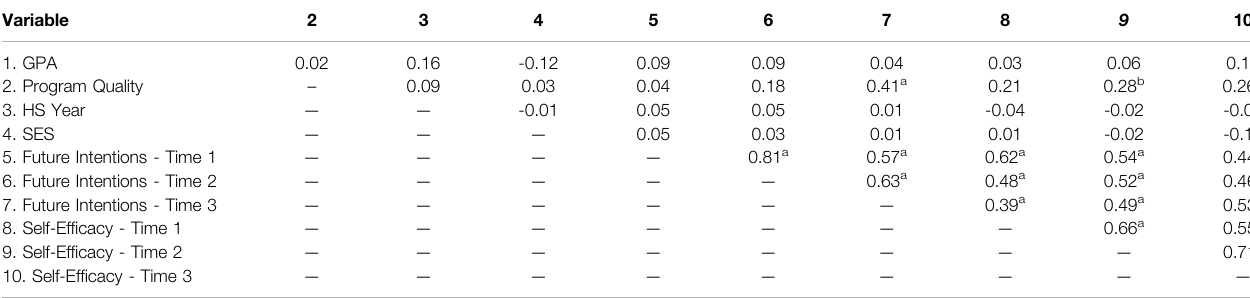
TABLE 2 | Study 1: Zero-Order Correlations (N (cid:1) 75). Variable